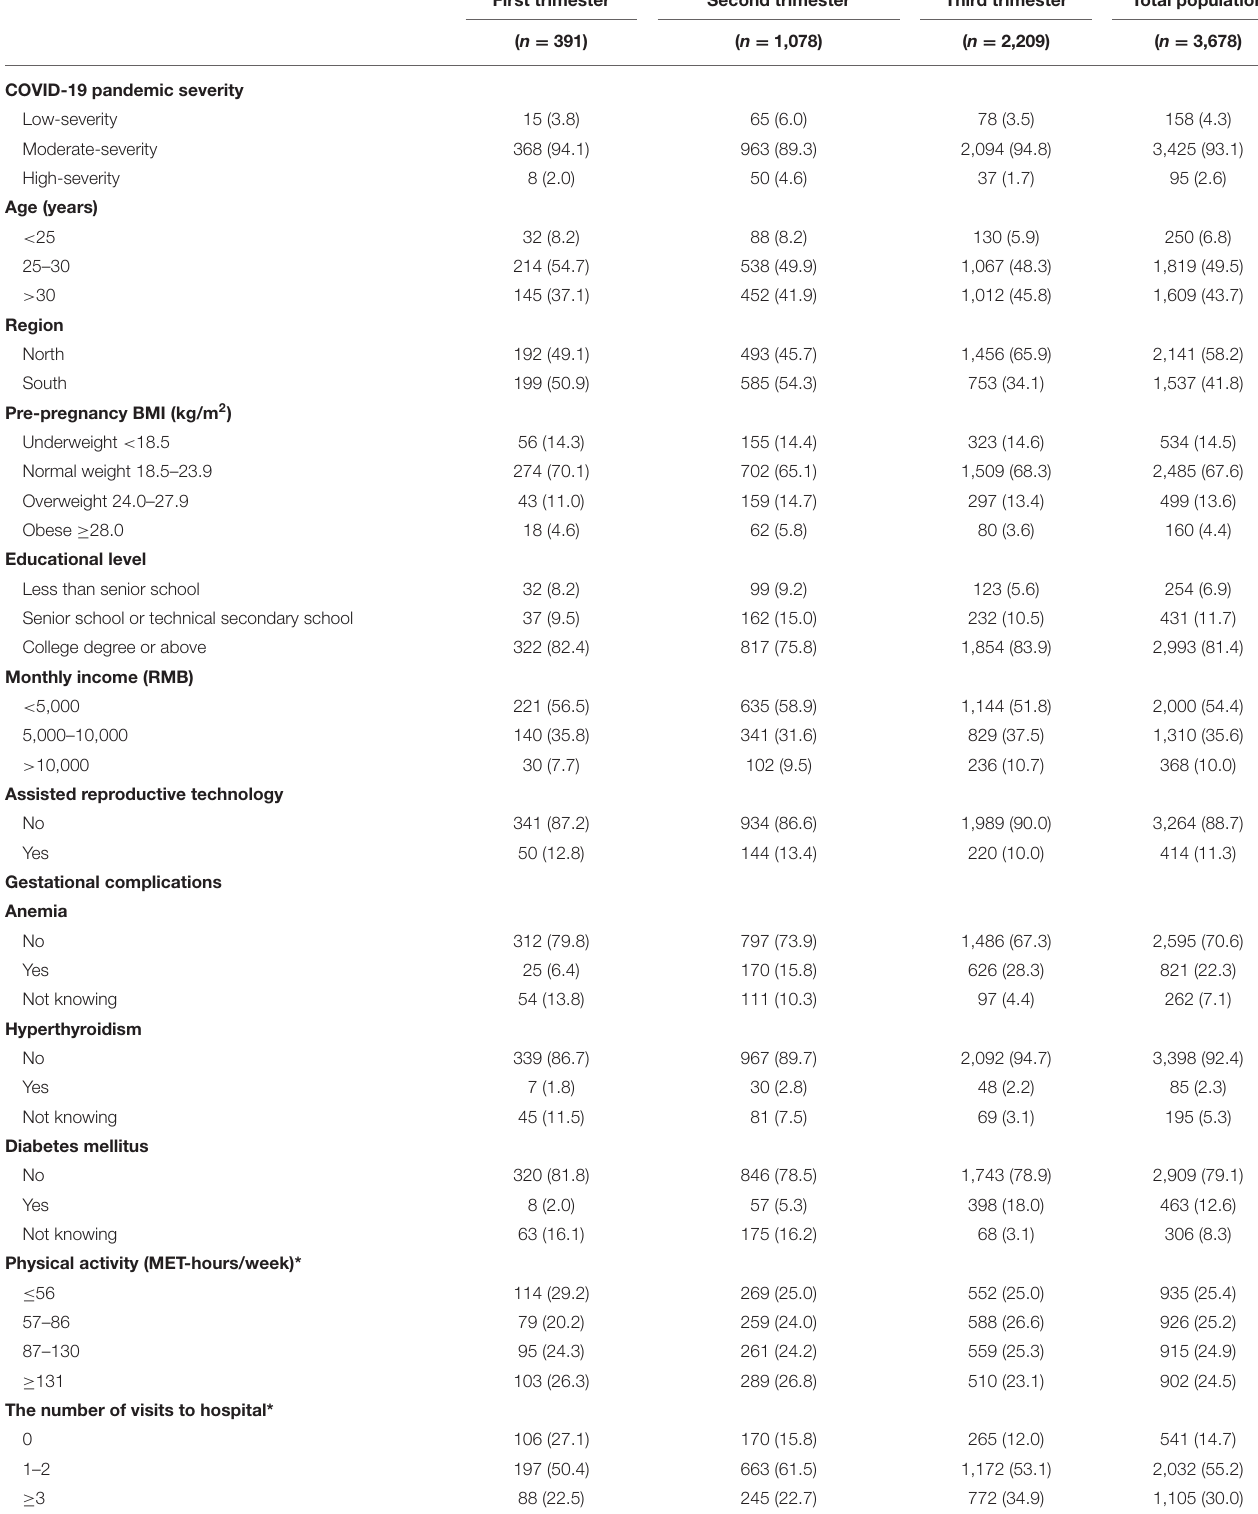
TABLE 1 | Demographic characteristics of pregnant